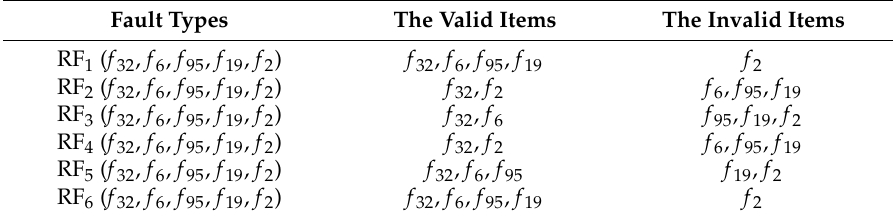
Figure 12 . The feature selection tree of the REB faults. Figure 12. The feature selection tree of the REB faults. Table 4. The DFV valid items and invalid items of each fault type.